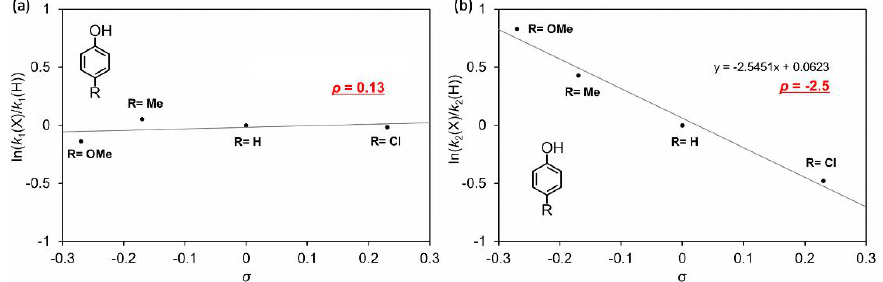
Figure 11. Hammett plots for k 1 ( a ) and k 2 ( b ) in the presence of various phenol derivatives ( p - methoxy (OMe), p -methyl (Me), p -chloro (Cl) substituted phenols and unsubstituted phenol).